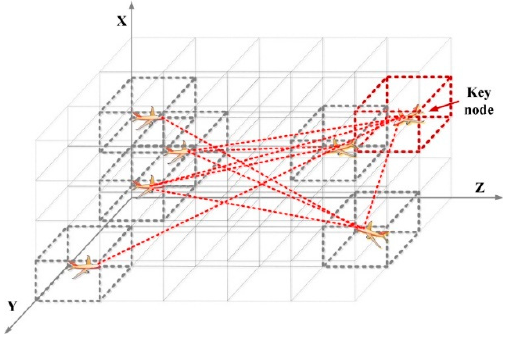
Figure 2. Conceptual graph for key node selection.